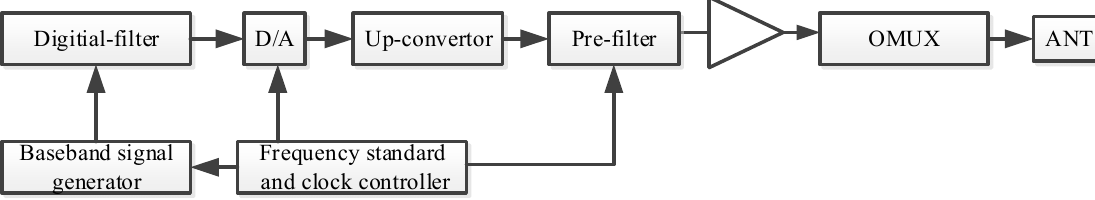
Figure 1. Navigation payload transmission channel model.